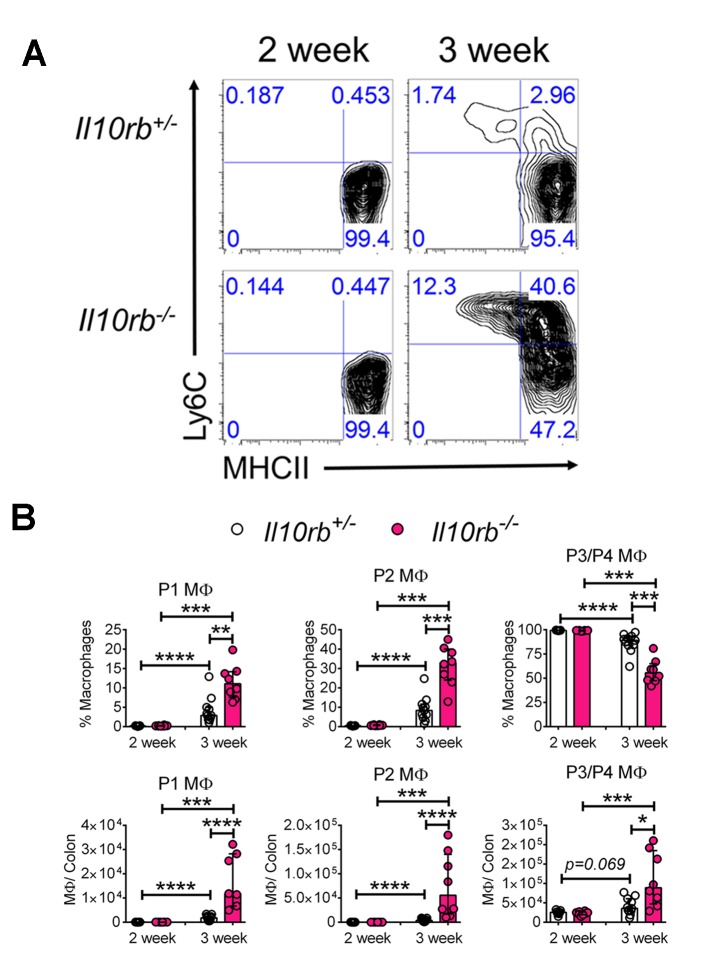
Colonic lamina propria macrophage dysfunction in 3–4 week old Il10rb-/- mice.Representative FACS plots of (A) MΦ subsets, gated on CD45+CD11b+ CD11cintCD103-CD64+ cells in the LP of Il10rb-/- and littermate Il10rb+/- mice at 2 and 3–4 weeks. Gating strategy is shown in the accompanying Figure 2—figure supplement 1. Comparison of the frequencies and absolute numbers per colon of (B) LP MΦ subsets is shown for Il10rb-/- vs control Il10rb+/- mice at 2 and 3–4 weeks of age. Results are pooled from 2 to 3 litters leading to 7–11 mice in each group. *p<0.05, **p<0.01, ***p<0.001, ****p<0.0001, Mann-Whitney U test. Data represents Median with IQR. Additional data file (Figure 2—figure supplement 2) showing minimal alterations in colonic lymphocytes and dendritic cells in 3–4 week old Il10rb-/- mice is provided.